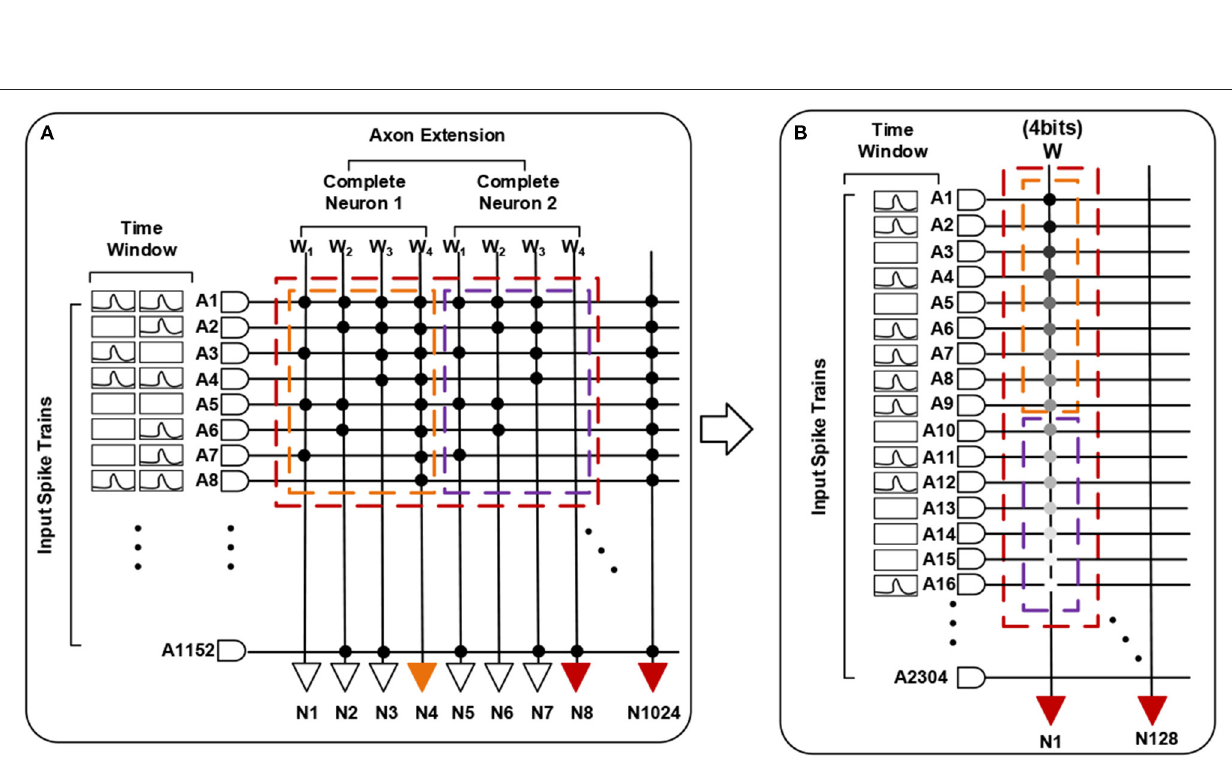
Frontiers in Neuroscience |